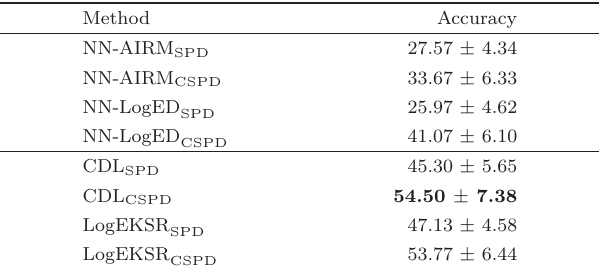
Table 3 Recognition rates with standard deviations, virus cell dataset Method